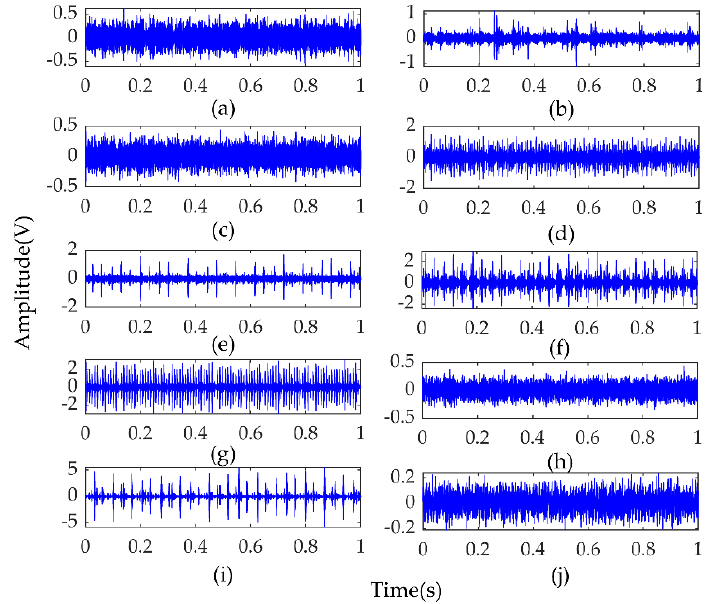
Figure 5. Experimental platform for acquiring vibration signals from rolling bearings.